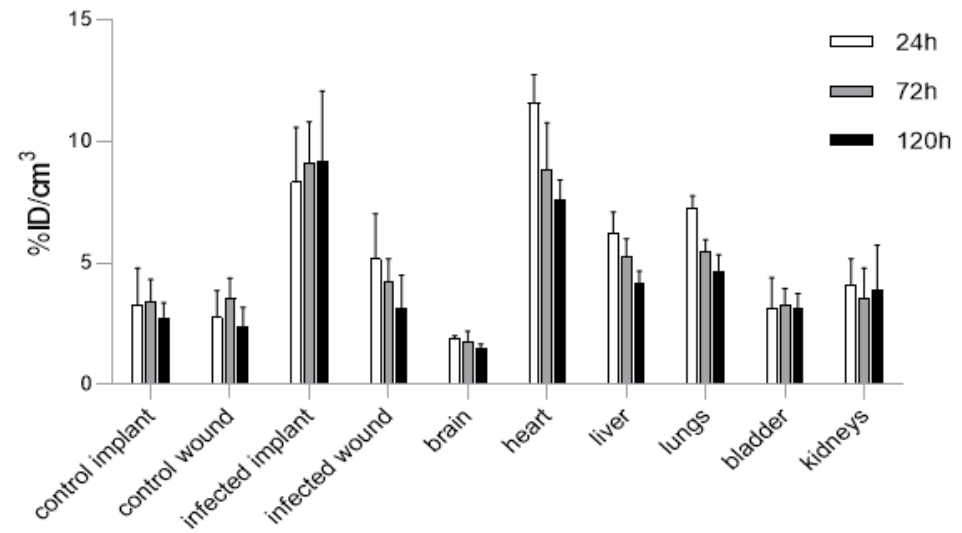
Figure 2. Biodistribution of 111 In-labeled 4497 antibody targeting S. aureus in seven BalB/C mice with a subcutaneous implant infection at multiple timepoints [14]. The bars represent 24, 72 and 120 h after IV administration. At 72 and 120 h, significantly higher uptake was seen at the implant infec- tion site and the heart compared to all the other organs or targeted areas ( p ≤ 0.002). The activity in each mouse decreased over time. This decrease was due to the effec- tive half-life of 4497- 111 In. The analyses showed an effective half-life of 59 h (Figure 3) for 4497-IgG1-CHX-A”- 111 In. The physical half-life of 111 In is 67 h, resulting in a decay of 0.78 after 24 h, 0.48 after 72 h and 0.29 after 120 h after the time of injection. The biological half- life was calculated to be 522 h.